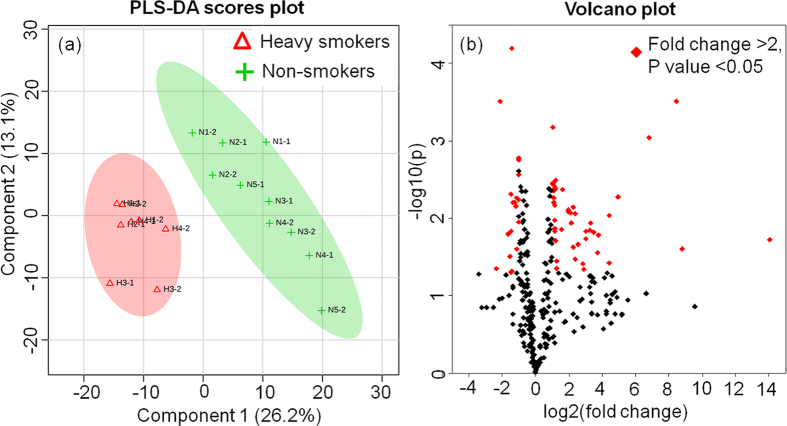
(a) PLS-DA scores plots for comparison of the global metabolite profiles in (∆) heavy smokers and (+) non-smokers. 26.2% and 13.1% are the scores of the component 1 and 2, respectively, in the PLS-DA analysis. (b) Volcano plot of the 294 features with VIP values > 1 in PLS-DA analysis. Volcano plot is a combination of fold change and t-tests. The 62 features with a fold change >2 and p-value < 0.05 were marked in red.